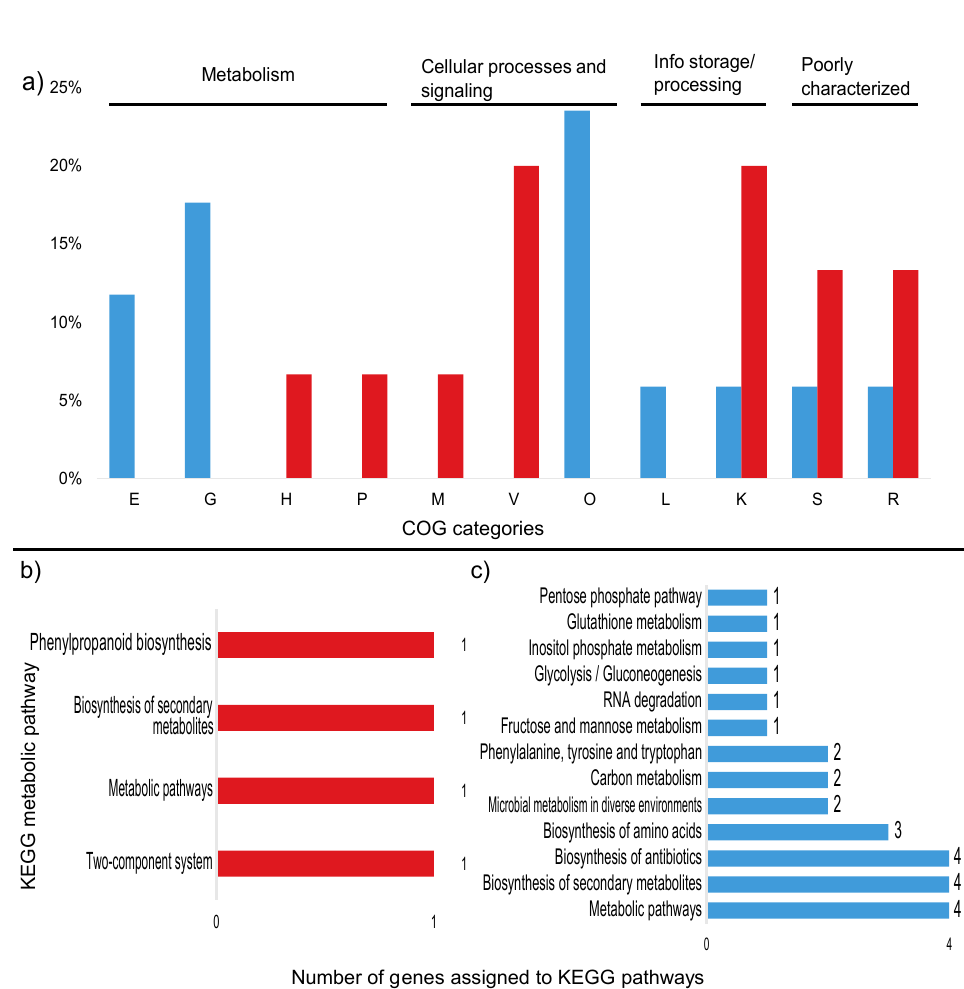
Figure 4. Percentage of differentially expressed transcripts assigned to COG categories and number of KEGG pathways up and down regulated in the high sugar treatment. ( a ) Percentage of upregulated (red) and downregulated (blue) transcripts assigned to COG categories. ( b ) Number of upregulated transcripts assigned to KEGG pathways. ( c ) Number of downregulated transcripts assigned to KEGG pathways. Unassigned transcripts are not shown. E: amino acid transport and metabolism; G: carbohydrate transport and metabolism; H: coenzyme transport and metabolism; M: cell wall / membrane / envelope biogenesis; V: defense mechanisms; P: inorganic ion transport and metabolism; O: post-translational modification; L: replication, recombination, and repair; K: transcription; S: function unknown; R: general function and